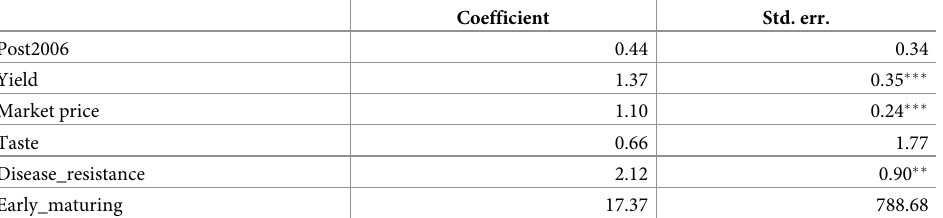
Table 7. Results of the maximum likelihood estimation of the conditional (fixed-effects) logistic regression model.